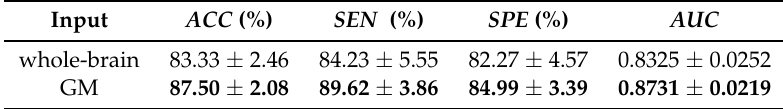
Table 13. Classification performance of models with different inputs for T1 task.